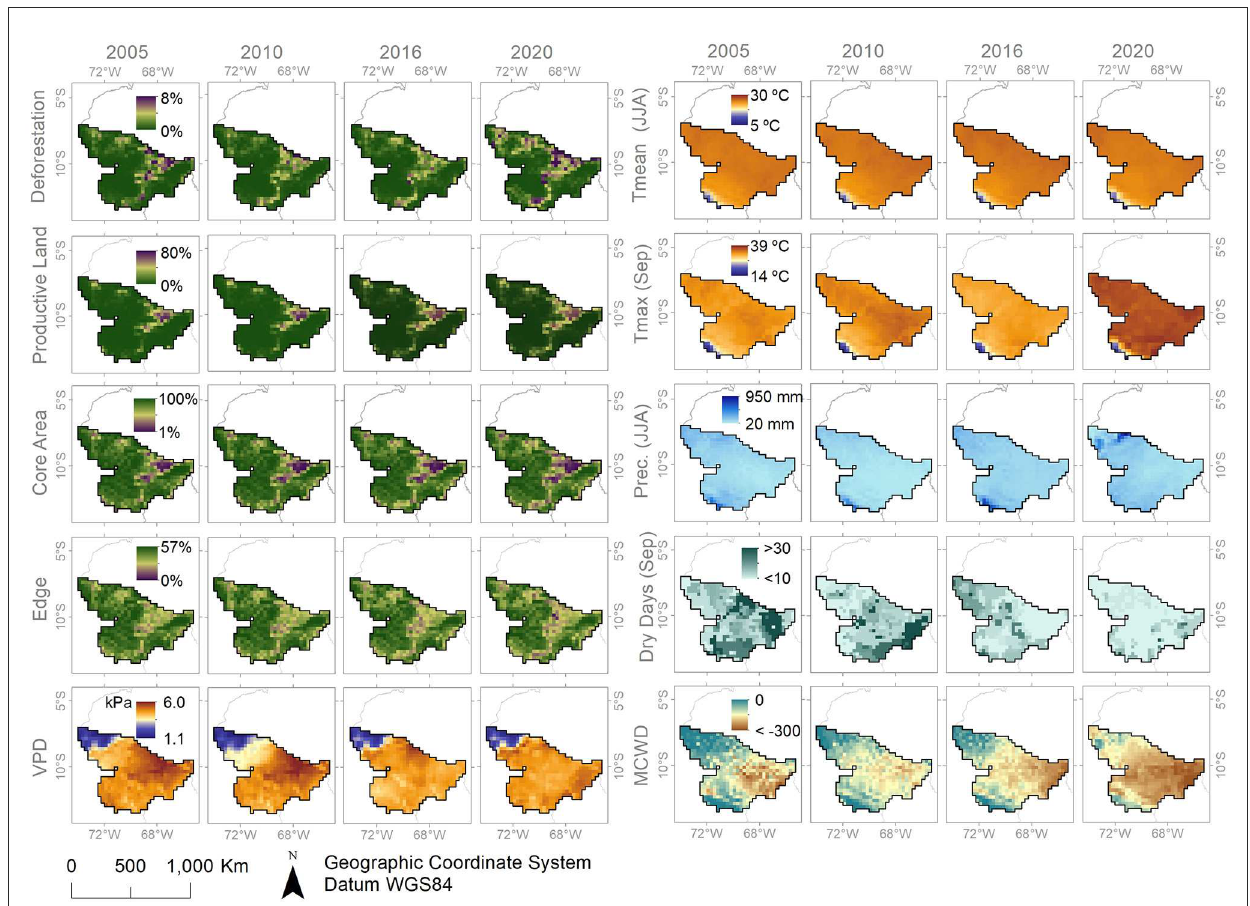
FIGURE2 Spatial distribution of land use and climate predictor variables. “Productive Land”: percentage of productive areas, “Core”: core area, “Deforestation”: annual percentage of deforested area, “Edge”: forest edge area, “MCWD (Sep)”: MCWD index for the month of September, “Dry Days (Sep)”: number of consecutive days with precipitation below 1mm of September, “Prec. (JJA)”: total precipitation of June, July, and August, “Tmax (Sep)”: maximum temperature of September, “Tmed (JJA)”: average temperature of June, July, and August, “VPD (Sep)”: vapor pressure deficit of